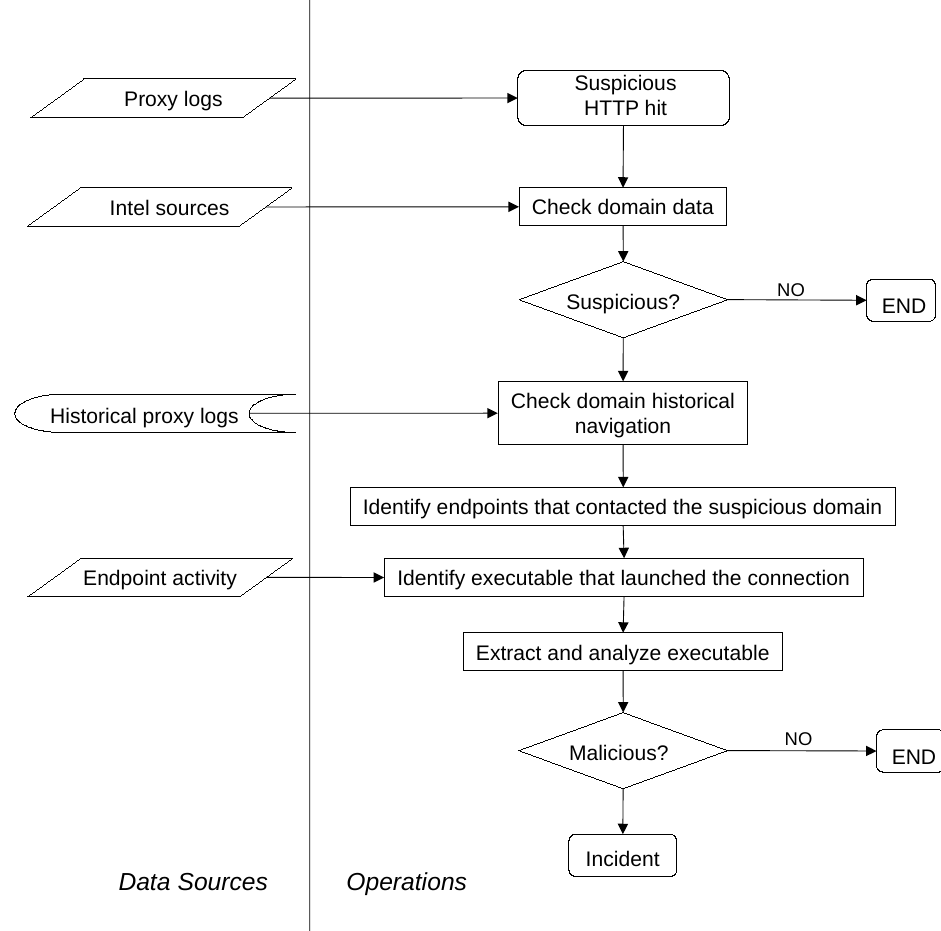
Figure 3. Playbook for the analysis of suspicious HTTP